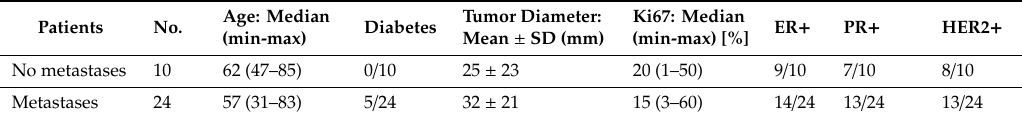
Table 2. Characteristics of patients with breast